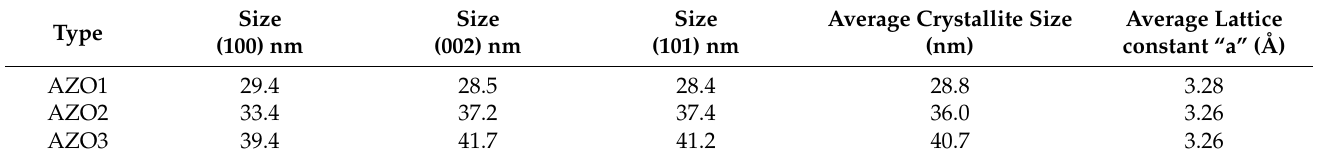
Table 3. Crystallite size calculated from XRD analysis. Adapted from Ref.